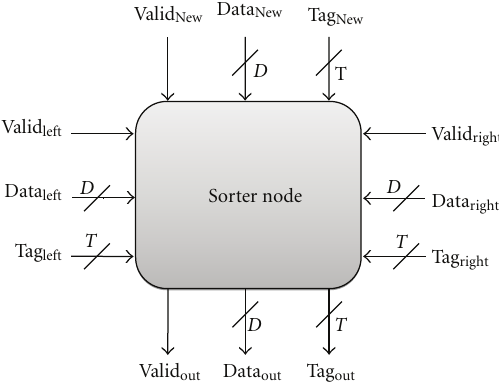
Figure 7: Sorter node interface. D = Data Width, T = Tag